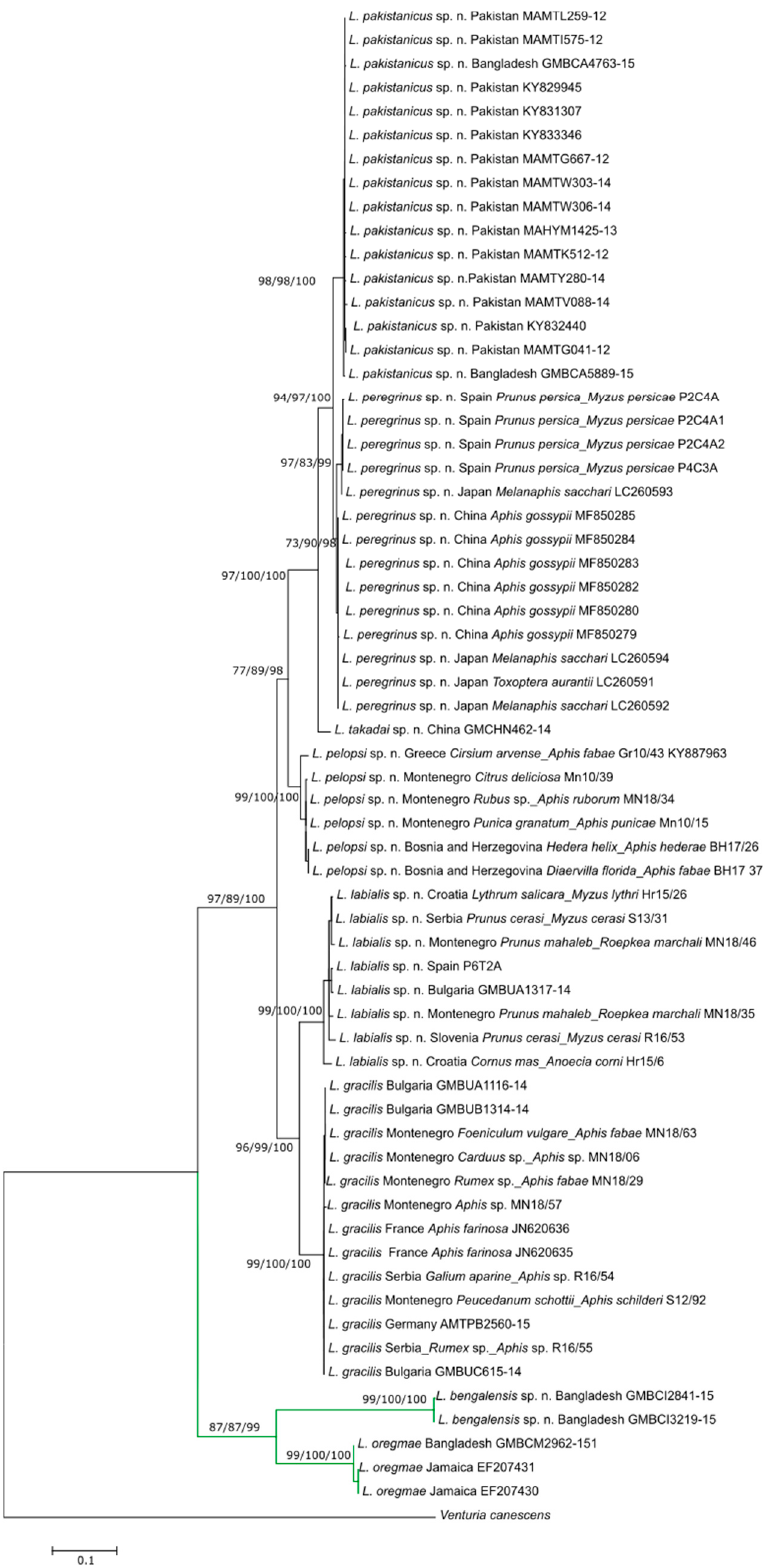
Figure 1. Phylogenetic tree based on 63 cytochrome oxidase c subunit I (COI) sequences of Lipolexis . obtained using Neighbor Joining analysis. Bootstrap values/Bayesian posterior probabilities above 50% are shown on the branches in ML/NJ/Bayesian analysis order. Specimen data are presented in